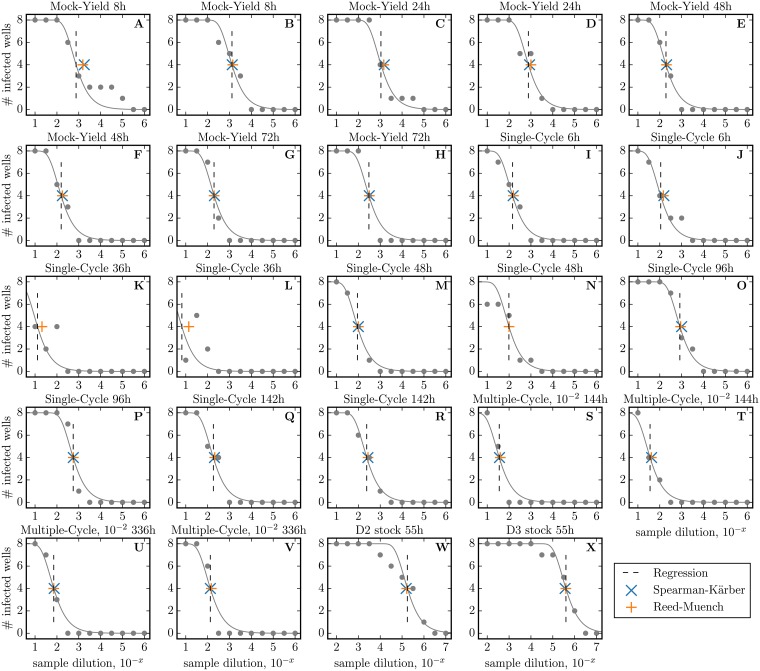
Calculation of the TCID69 and TCID50.The vertical dashed line indicates the sample dilution corresponding to 1 TCID50, i.e. an estimate of the dilution at which 4/8 wells are infected. This dilution is determined using a least-square regression of Eq (1) to the # of infected wells (grey line). From this TCID50, we compute TCID69 = TCID50 × ln(2). The TCID50 obtained using the Spearman-Kärber (cross) and Reed-Muench (plus) methods are also shown for comparative purposes.